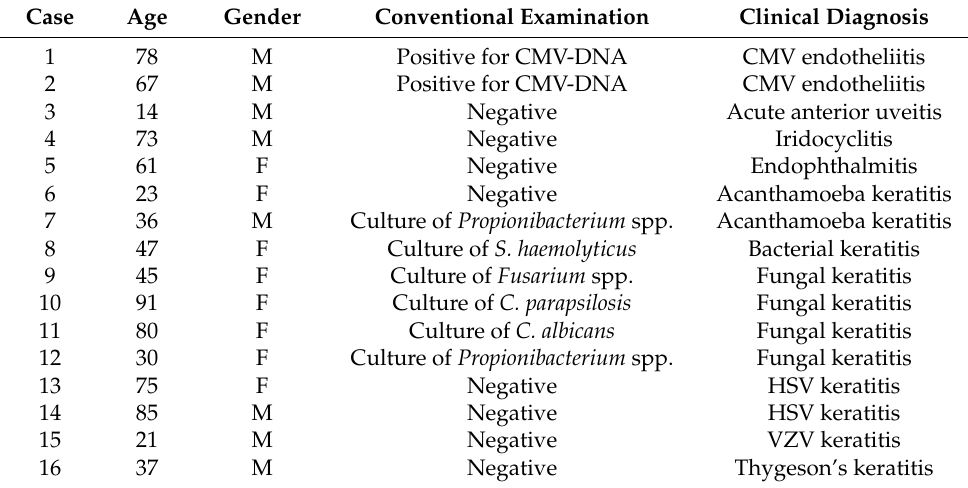
Table 1. Summary of 16 patients with ocular